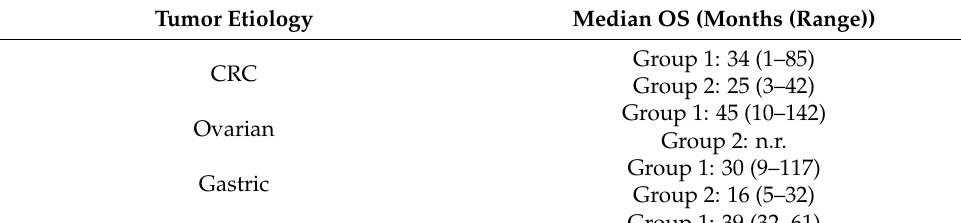
Table 2. Median overall survival for each tumor etiology (CRC = colorectal cancer; OS = overall survival; n.r. = not reached).